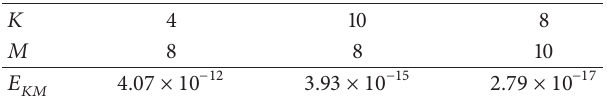
Table 6: The maximum errors of 𝐸 𝐾𝑀 for different values of 𝐾 and 𝑀